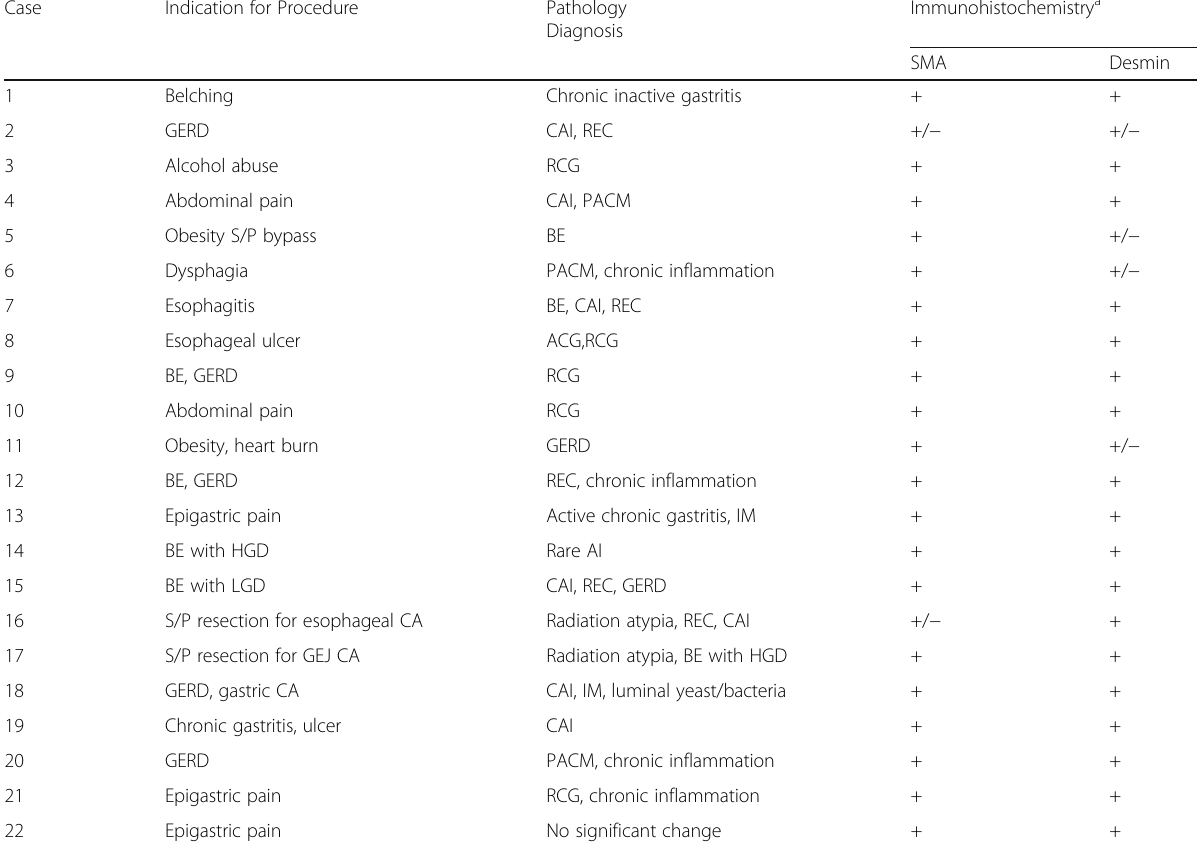
Table 1 Clinicopathologic Features of Gastroesophageal Specimens with Multinucleated Stromal Giant Cells